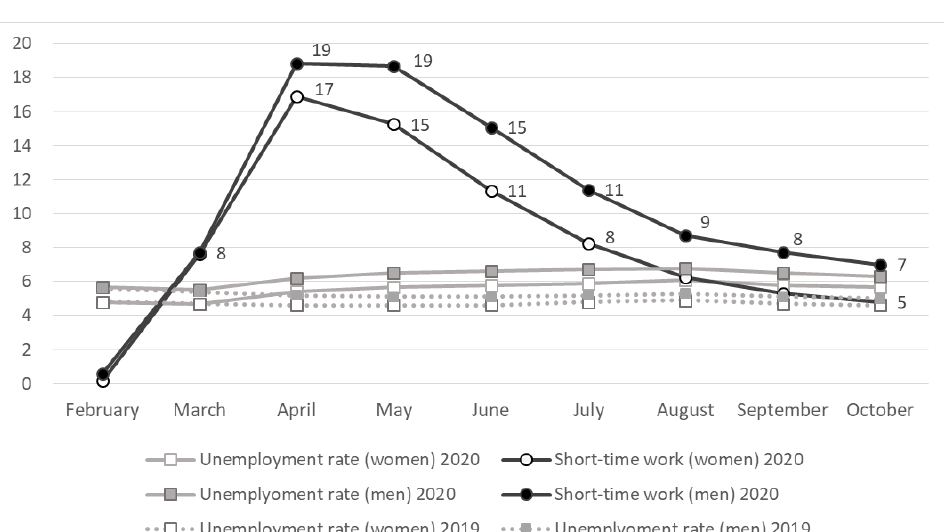
Figure 1 : Unemployment rate by gender and share of women and men receiving short- time work benefits out of all employees, Germany by month in 2020